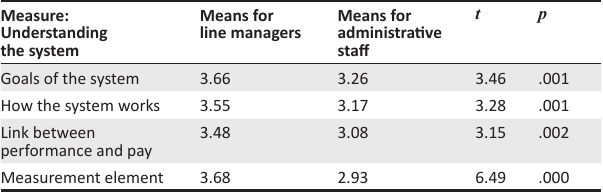
TABLE 2: Understanding the aspects of the pay-for-performance